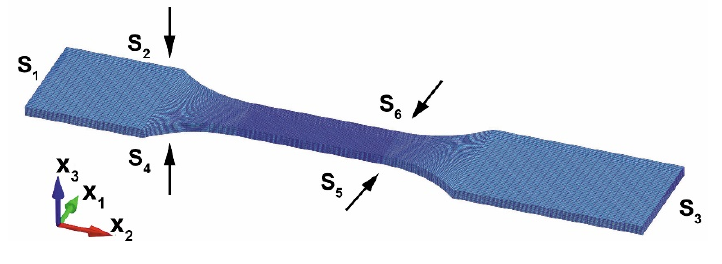
Figure 2. Scheme of boundary conditions.